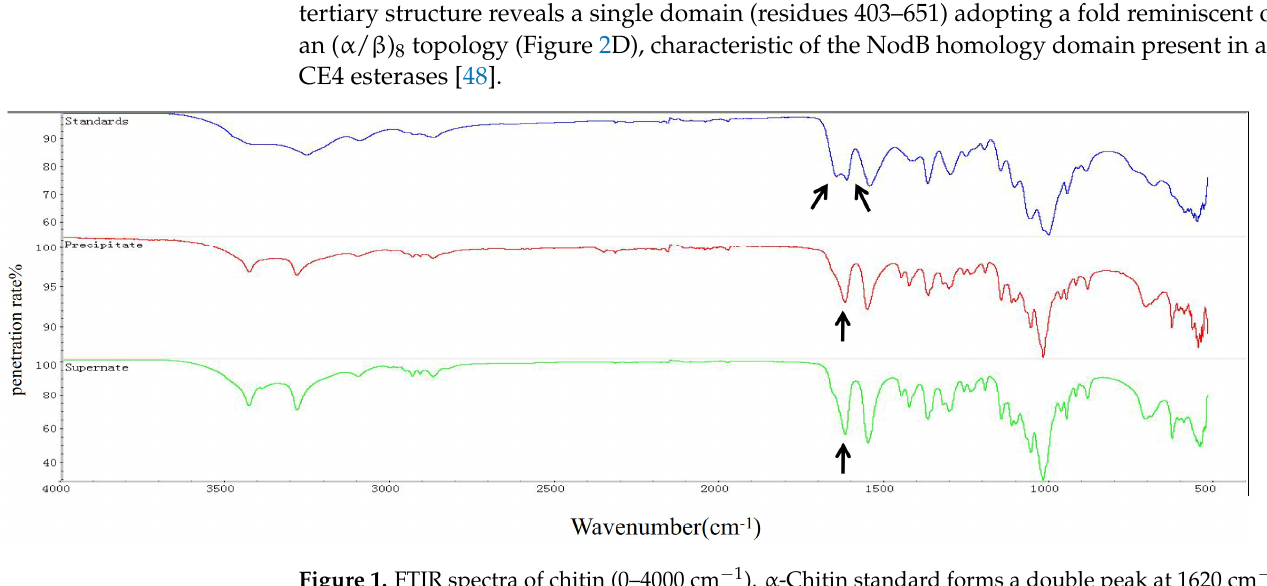
Figure 1. FTIR spectra of chitin (0–4000 cm −1 ). α-Chitin standard forms a double peak at 1620 cm −1 and 1652 cm −1 (the blue curve); the chitin extracted from the precipitation of T. weissflogii had a single peak at 1625 cm −1 (the red curve); the chitin extracted from the supernatant of T. weissflogii had a single peak at 1625 cm −1 (the green curve). The arrow indicates the location of the characteristic peaks.